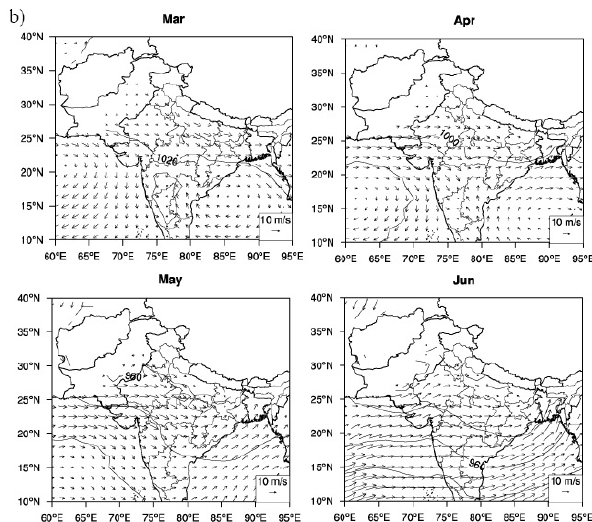
Fig. 2b. Mean geopotential height (m) and horizontal wind (m/s) Figure 2b) : Mean geopotential height (m) and horizontal wind (m/s) at 900 hPa from at 900hPa from 1998 to 2007 for the month of March, April, May 1998 to 2007 for the month of March, April, May and June. ERAInterim and June. ERAInterim (http://www.ecmwf.int/research/era/do/get/ era-interim) dataset were used for the above analysis. Locations (http://www.ecmwf.int/research/era/do/get/era-interim ) dataset were used for the above analysis. where the surface geopotential height is higher than the 900mb Locations where the surface geopotential height is higher than the 900mb geopotential height geopotential height have been masked have been masked out.